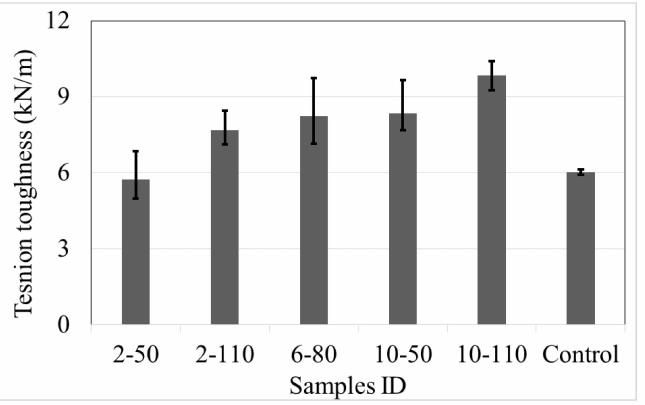
Figure 13. Tensional toughness of control samples and concrete with recycled PET